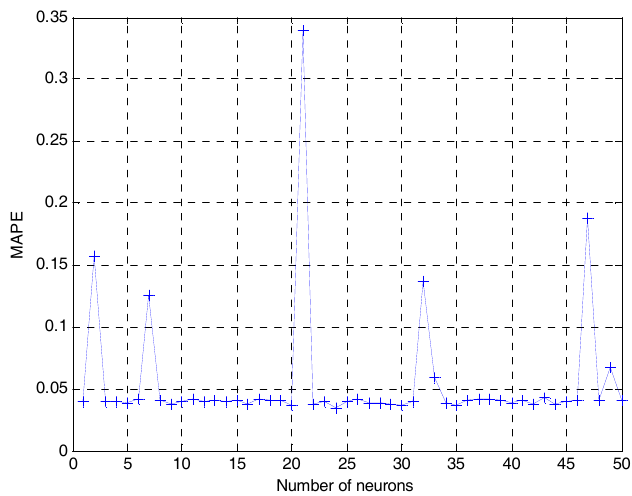
Figure 6. The trial and error results of Elman model.